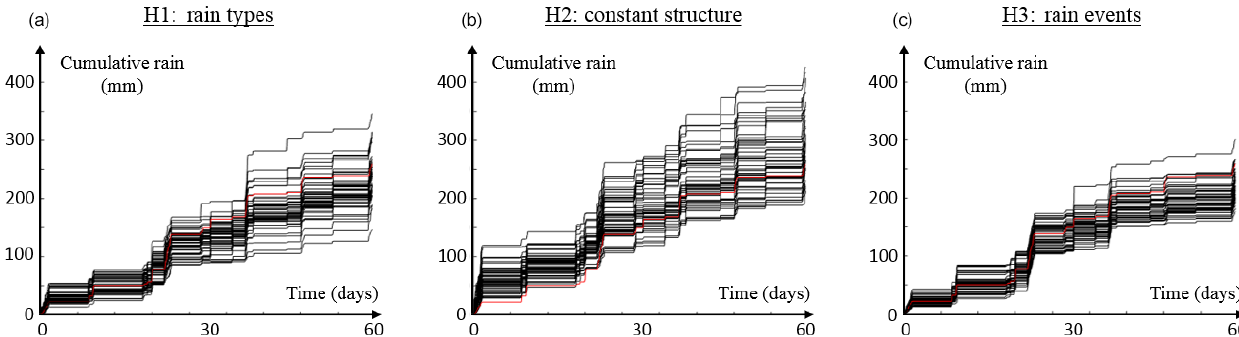
Figure 6. Reproduction of the cumulative rain height (averaged over the whole network) for the three tested hypotheses. (a) Rain is stationary by rain type (H1), (b) rain is stationary during the entire summer period (H2), (c) rain is stationary by rain event (H3). The red line corresponds to the observations and the black lines correspond to simulations.